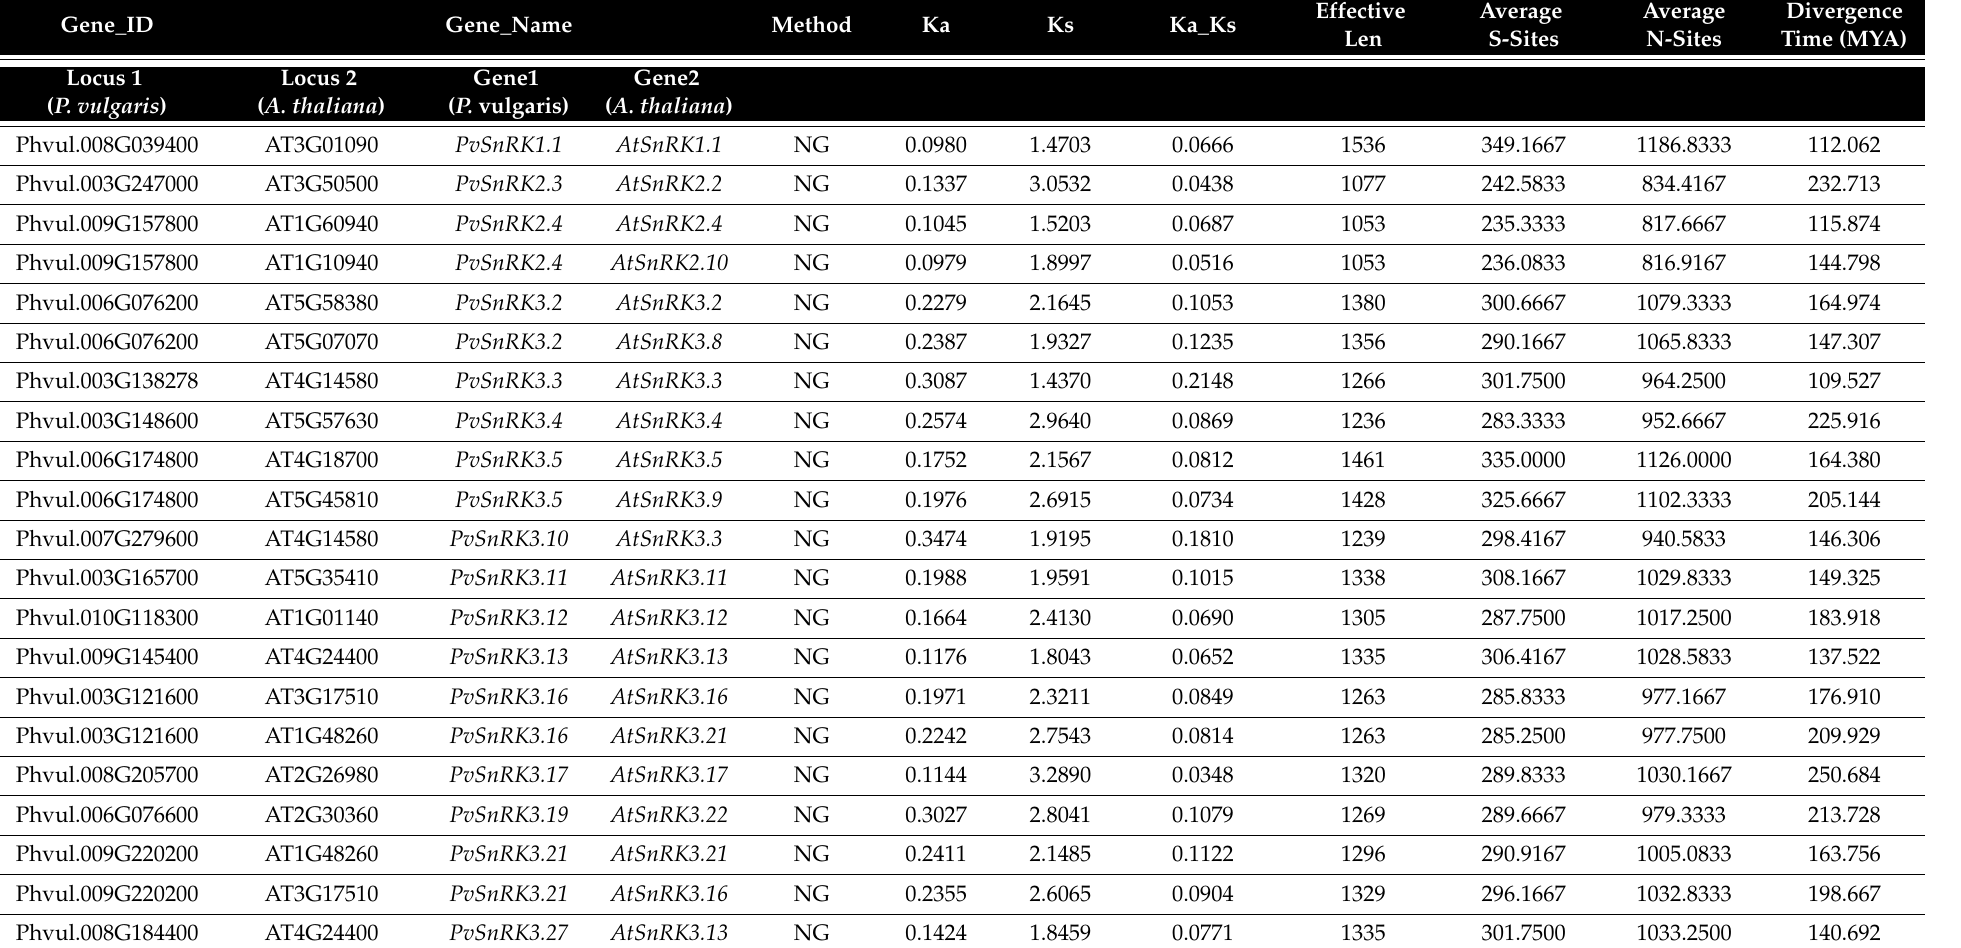
Table 2. One-to-one orthologous Ka/Ks relationships between P. vulgaris and A. thaliana